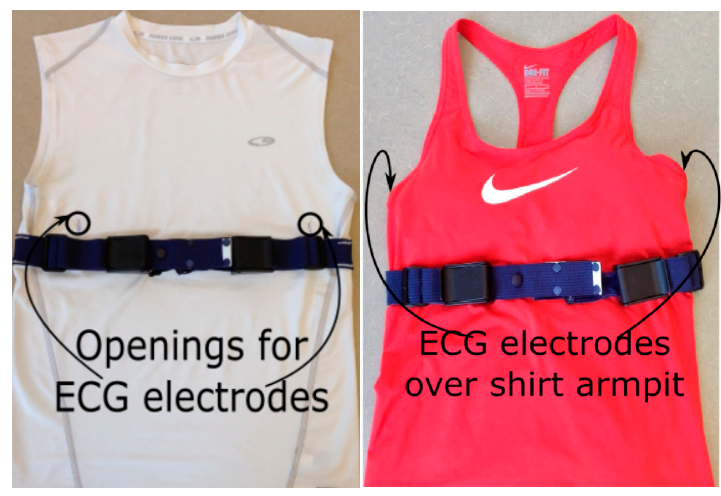
Figure 3. Instrumented T-shirt for male ( left ) and female user ( right ).